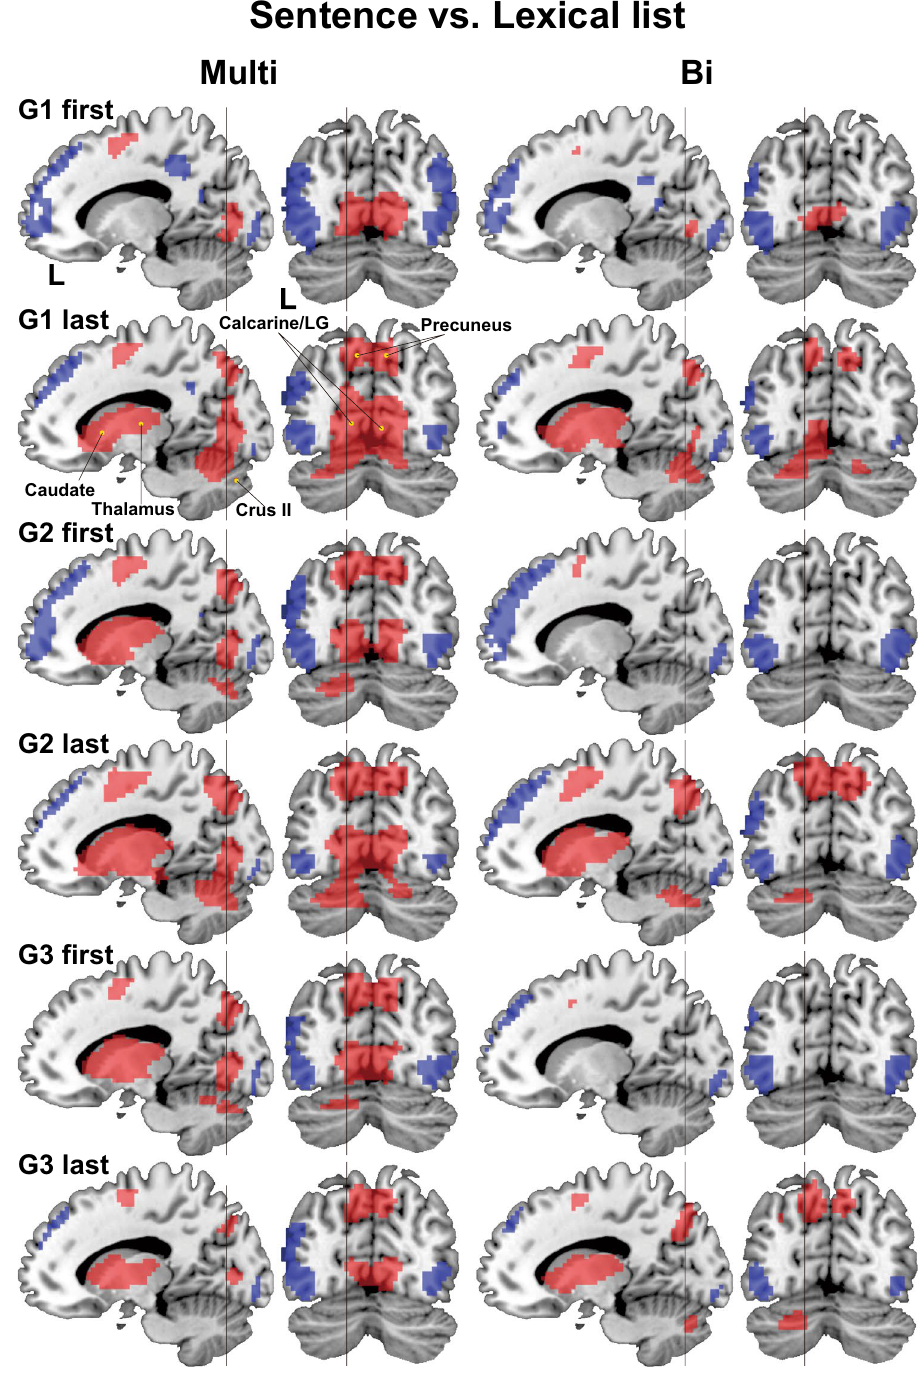
Figure 5. Differential activation in the other cortical and subcortical regions between the Multi and Bi groups. Activated regions for the Sentence–Lexical list contrast are shown in red, while those for Lexical list– Sentence are shown in blue (FWE corrected p < 0.05 for the cluster level). Parasagittal sections at x = −15 in MNI coordinates showed subcortical activations (red), whereas coronal sections at y = −72 showed occipital activations (red). The vertical lines indicate locations of those sections. Each yellow dot indicates the local maximum of activated regions on the medial structures (see Table S5). The Multi group showed significant activations in the basal ganglia/thalamus for G1 last, which maintained throughout the subsequent runs. Moreover, localized activations were observed in the visual cortex for the Multi group consistently during all of the runs. These images were created using SPM12 software (as above), MRIcron software (ver. 6.6.2013, https:// www. nitrc. org/ proje cts/ mricr on), and Adobe Illustrator (as